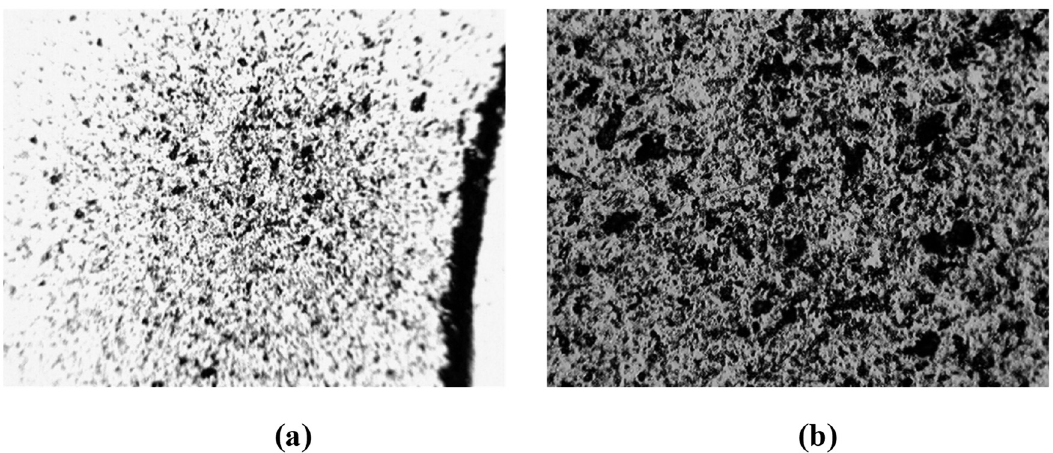
Figure 9: Microscope images of PMMA coating on glass substrate right after open - air PLD. The images were taken with ( a ) × 40 magni fi cation ( dimensions: X = 2,257 µm, Y = 1,674 µm ) and ( b ) × 100 magni fi cation ( dimensions: X = 903 µm, Y = 670 µm ) . Dark band on the right in image ( a ) is the mark made by microscope objective that occasionally touched the coating. The images were taken on the edge of the deposition zone, where deposited material did not cover whole surface.